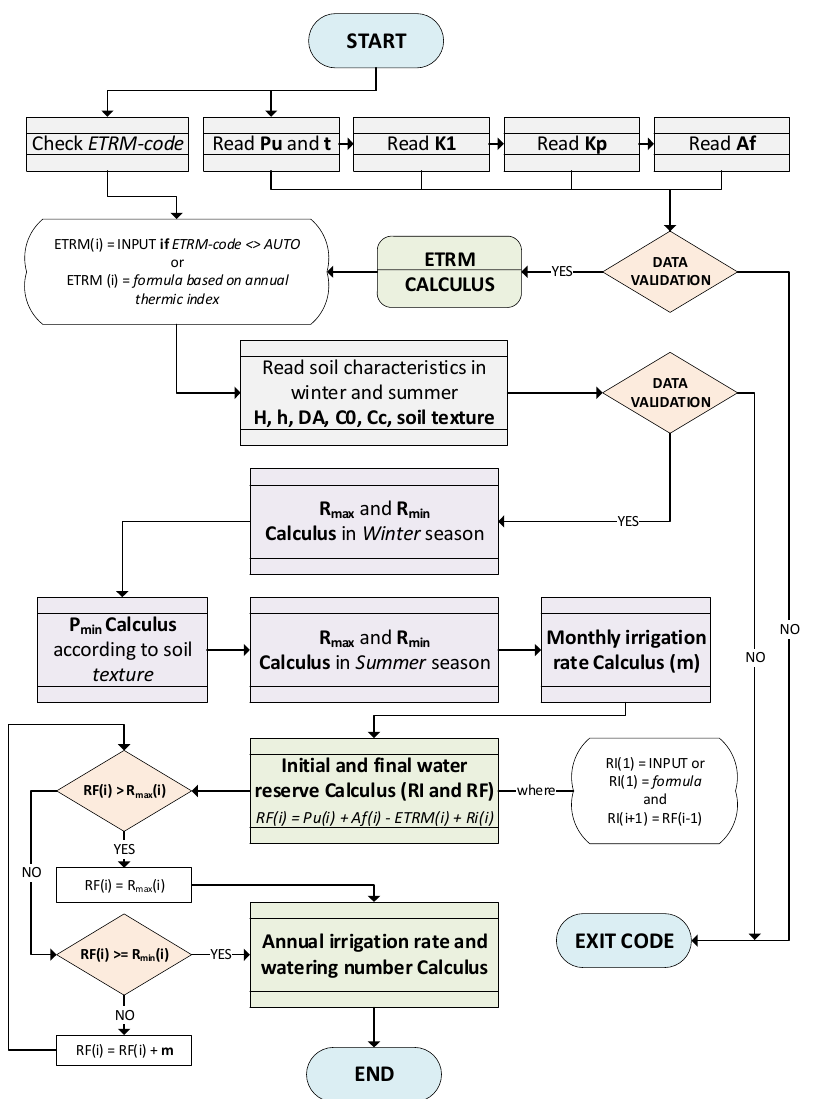
Figure 1. Flowchart (the variables are denoted in concordance with the coding)